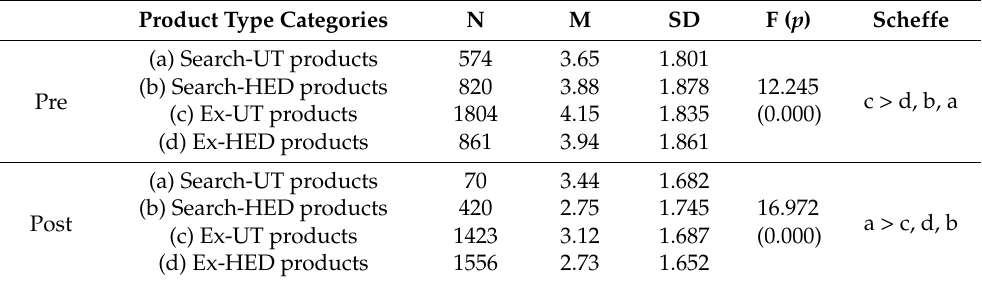
Table 14. One-way ANOVA results of purchase intention by product type category for the gen- eral